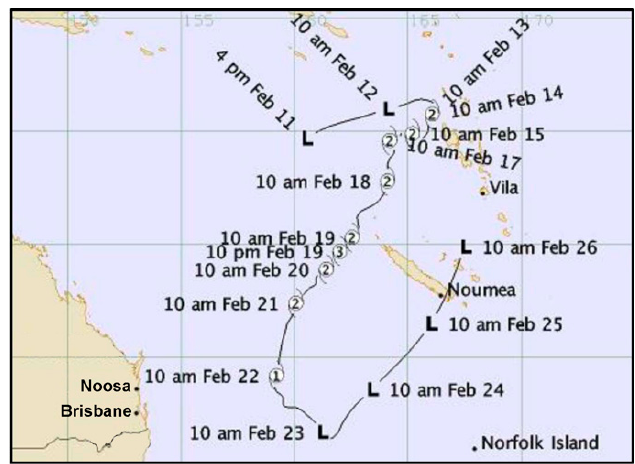
Figure 3. Tropical cyclone Oma track map. Source: Bureau of Meteorology.